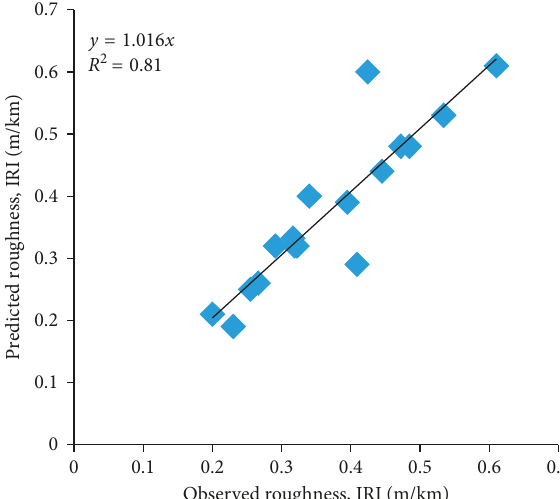
Figure 25: Scatter plot between observed versus predicted rutting for validation (2014).